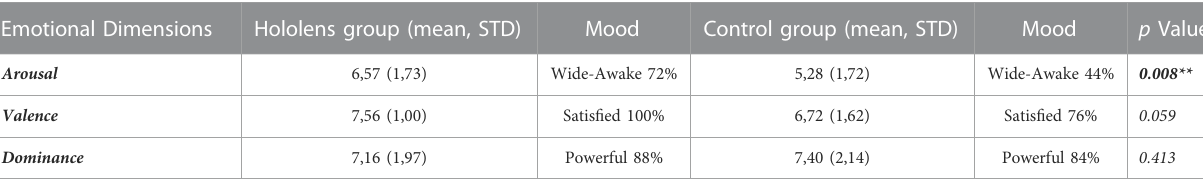
TABLE 8 SAM-Scale scores and p values. Emotional